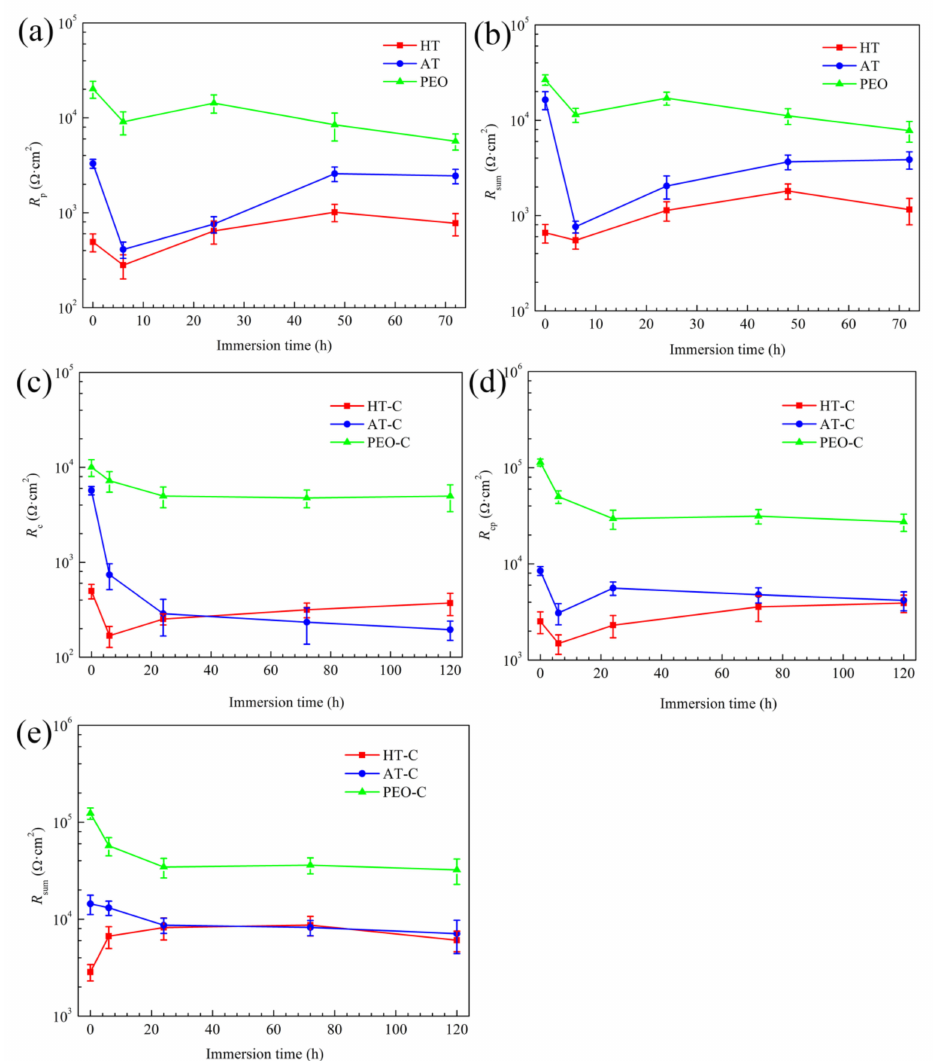
Figure 12. Fitting results of the resistance for pre-treated and CaPh-coated samples. ( a , b ) represent for the R p and R sum of the pretreated samples, respectively; ( c – e ) represent for the R c , R cp and R sum of the CaPh coated